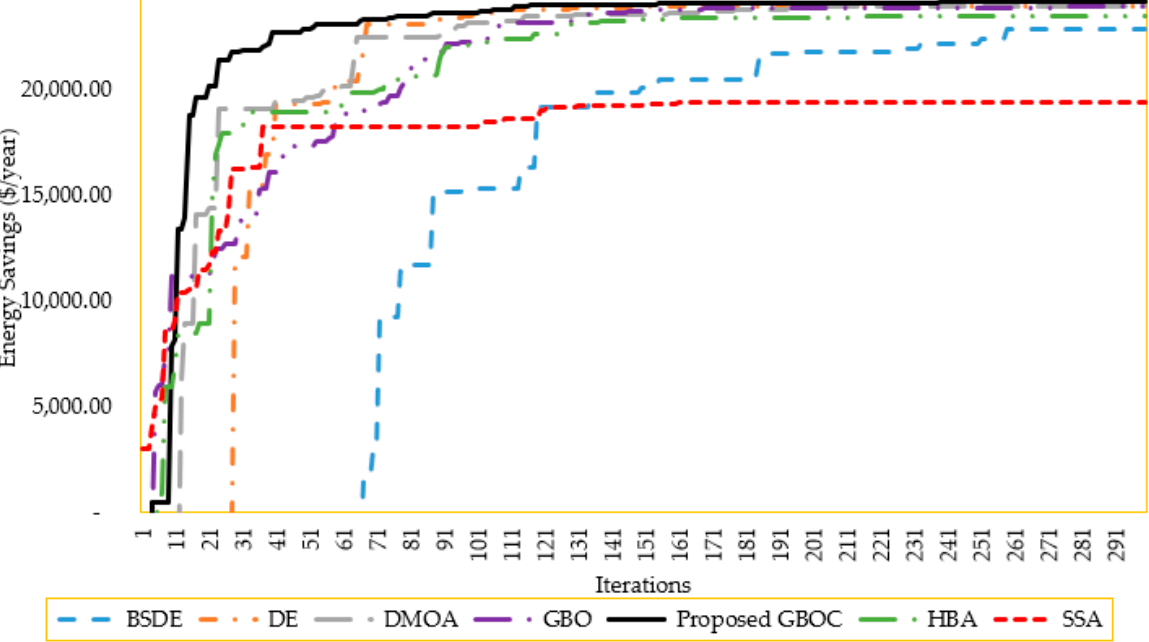
Figure 9. Convergence characteristics of GBOC, GBO, SSA, DMOA, DE, and HBA for the IEEE 33-distribution system for Scenario 2.